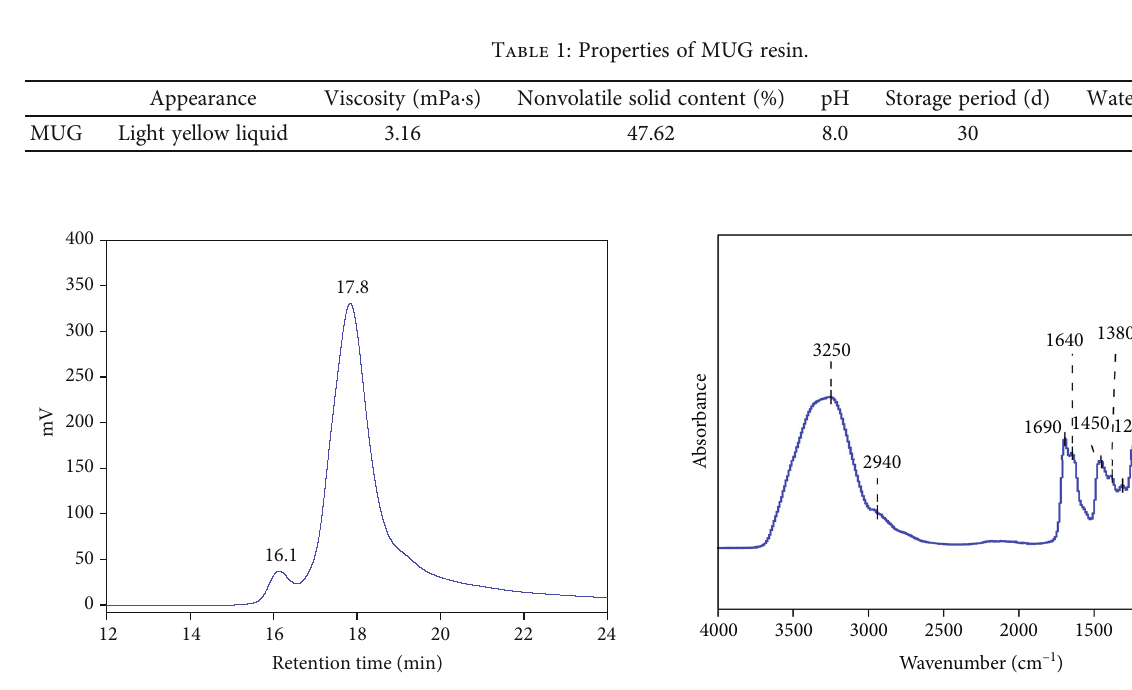
Figure 3: FTIR spectra of MUG